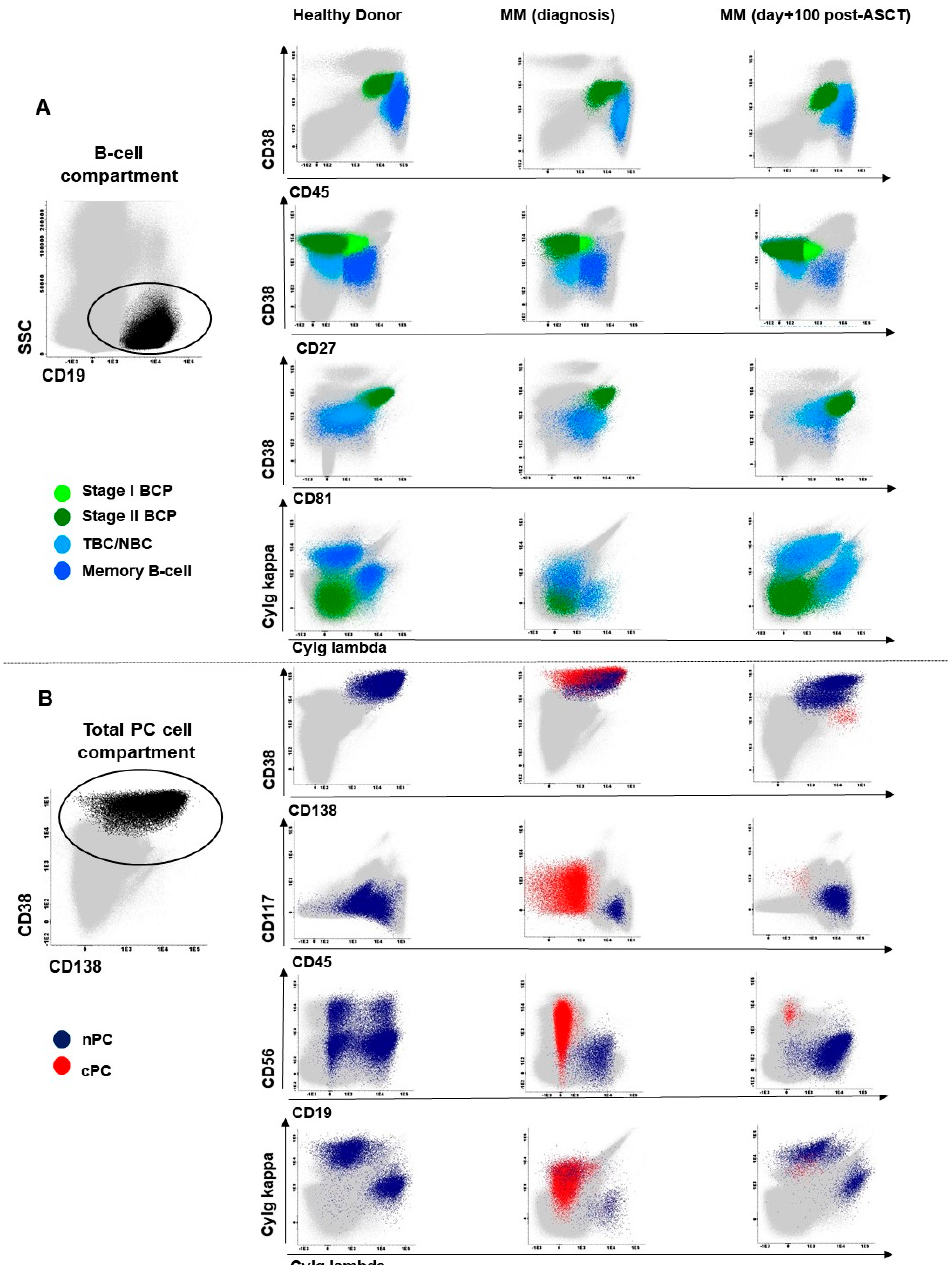
Figure 4. Illustration of the gating strategy used for identification of the different populations of B-cells and both normal and clonal plasma cells present in BM from a representative healthy donor, an MM patient studied at diagnosis and an infiltrated MM BM sample studied at day+100 after autologous stem cell transplantation (ASCT). In panel ( A ), total B-cells were identified as CD19 + and low sideward scatter (SSC) cells (left plot) and subsequently subdivided into stage I (CD27 + ) B-cell precursors (BCP; light green dots), stage II (CD27 - ) BCP (dark green dots), transitional/naïve B-cells (TBC/NBC; light blue dots), and memory B-cells (blue dots). In panel ( B ), the distributions of normal (polyclonal) plasma cells (nPC; dark blue dots) and clonal plasma cells (cPC; red dots), as defined based on their cytoplasmic (cy)Ig expression pattern, are shown. All dot plot graphical representations in the left column correspond to a representative healthy donor, while the middle and right column panels correspond to two MM patients studied at diagnosis (middle panel) and at day+100 post-ASCT (right panel). BM cells other than B-cells and PC are depicted as grey events. BM, bone marrow; MM, multiple myeloma;